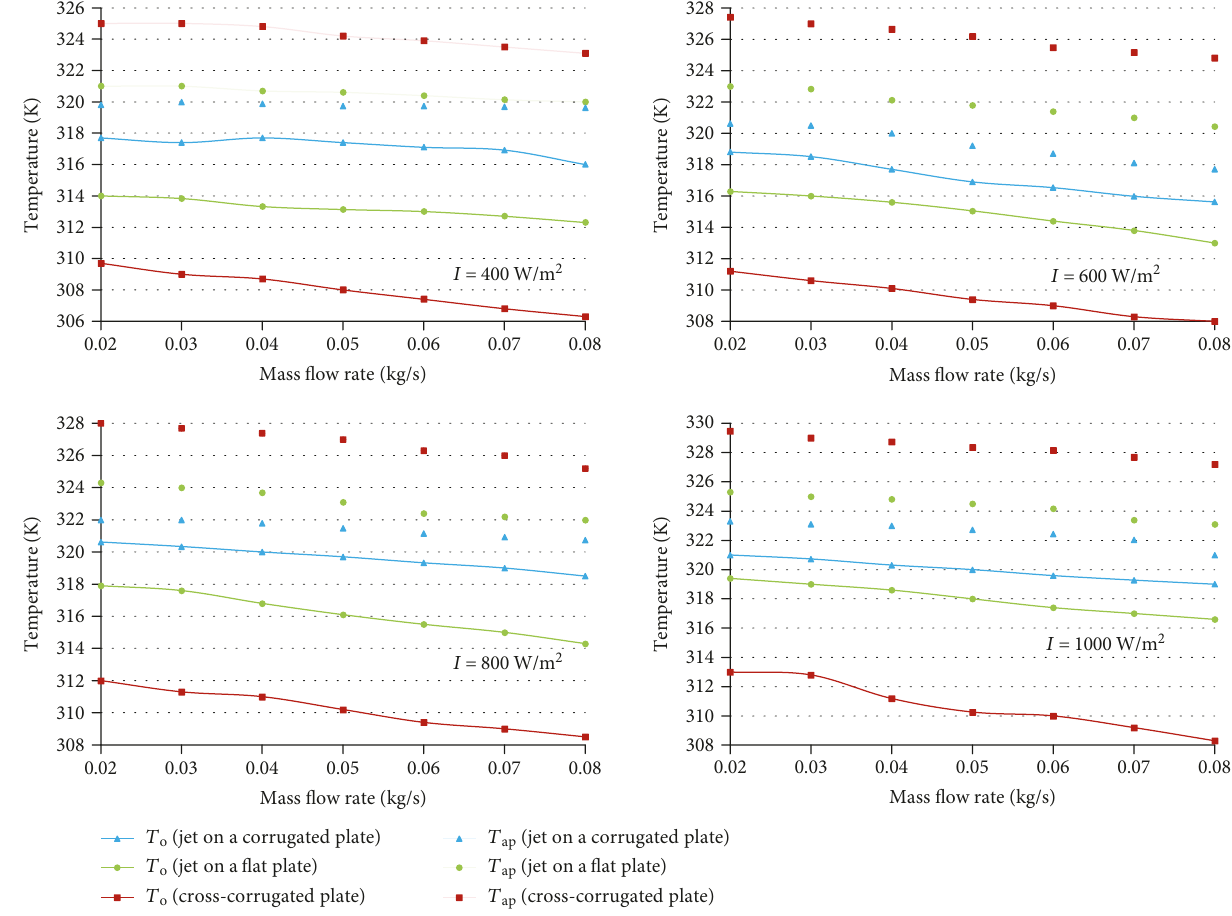
Figure 16: Absorber plate and outlet temperature of di ff erent collector designs versus mass fl ow rate for di ff erent solar radiation